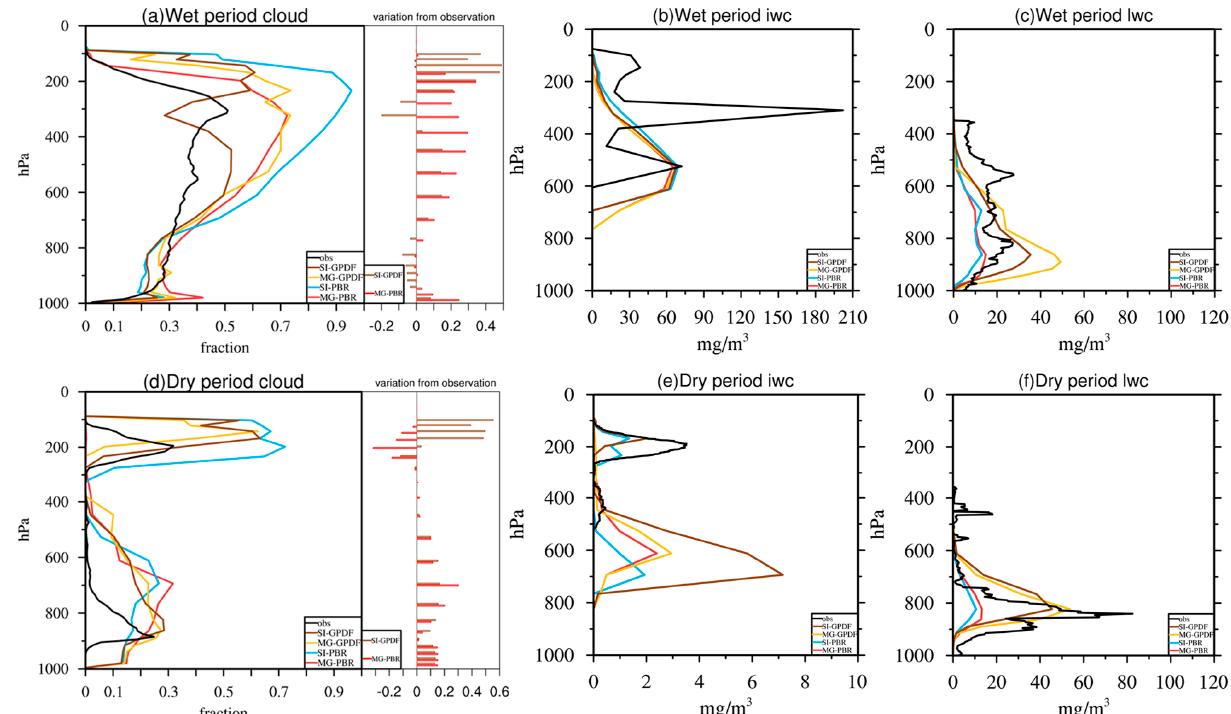
Figure 2. Vertical profiles of cloud fraction and the deviation from the observation ( a , d ), ice water content ( b , e ) and liquid water content ( c , f ) averaged in the wet (18–25 January, top) and dry periods (26–30 January, bottom) in the four tests, MG-PBR (red), SI-PBR (cyan), MG-GPDF (orange), and SI-GPDF (brown) in comparison with the observations (black).